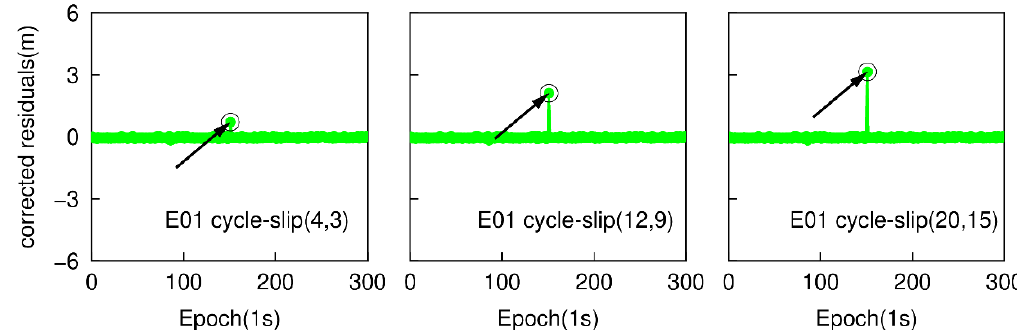
Figure 14. Specific small cycle-slip combinations detection results by checking the largest residual for E01. for